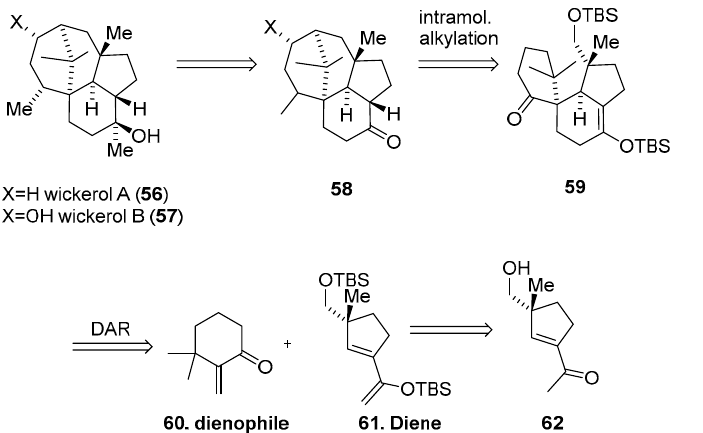
Scheme 15. Retrosynthetic approach to the synthesis of wickerol A 56 via DAR in the presence of chiral diene 61